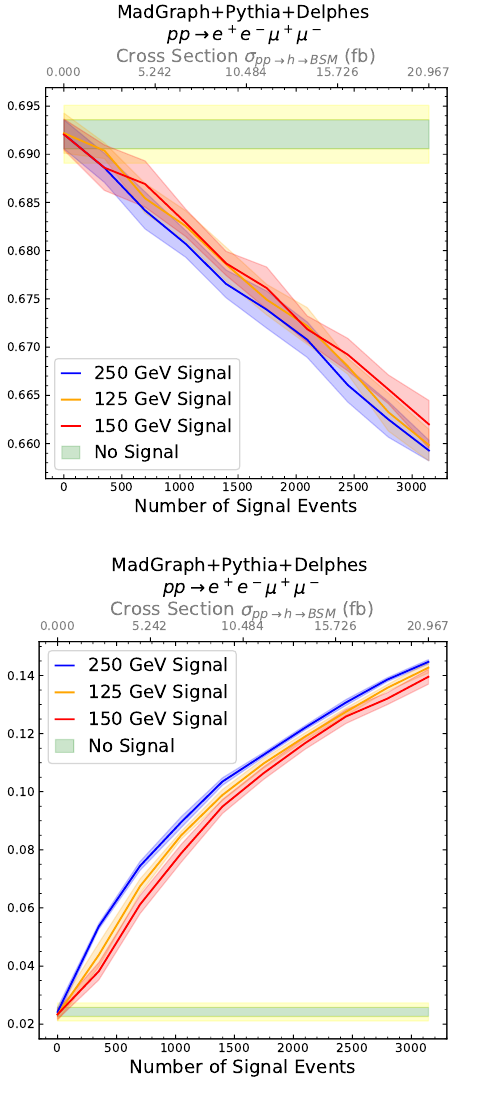
Figure 4 . BCE Loss. The average loss (top left), average score (top right), score standard de- viation (lower left), and maximum score (lower right) when using the MLC loss as a function of the number of injected signals. The green (yellow) band corresponds to the 1 σ (2 σ ) region of the background-only hypothesis. The bands for each signal correspond to the standard deviation across 10 independent signal injections. The upper axis provides the injected cross section, where the number of background events corresponds to 150 fb − 1